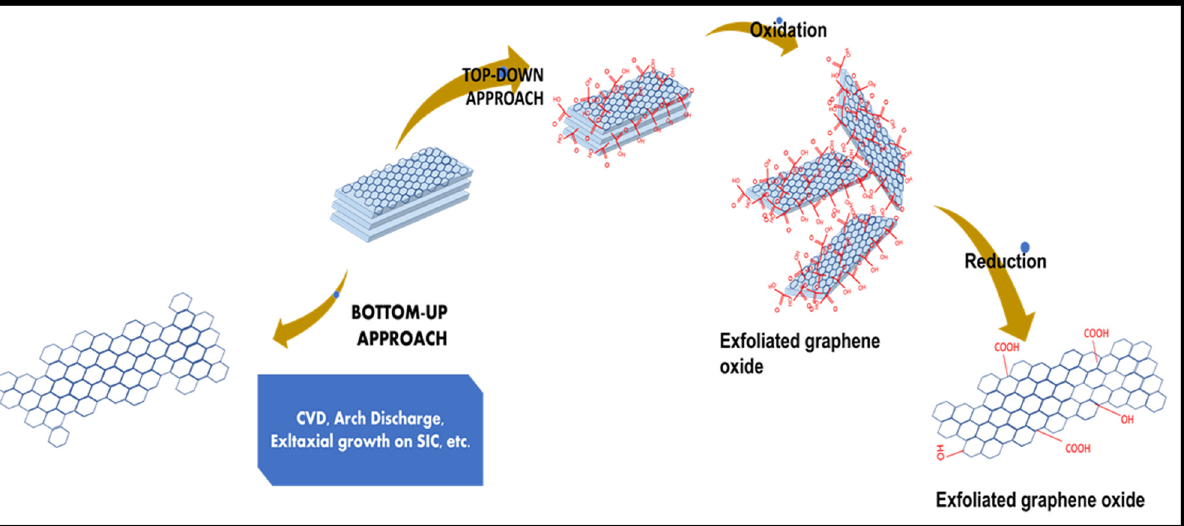
Figure 2: Schematic representation of the methods used for the synthesis of graphene, which is classi fi ed into top - down and bottom - up